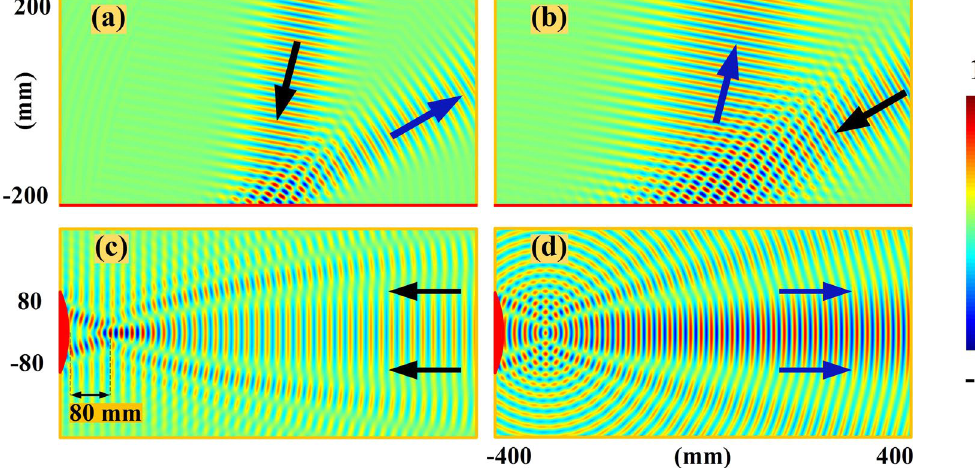
Figure 2. The near-fields of the negative reflection properties from the meta-mirrors. The demonstrations are based on the real part of the E-fields at 15 GHz, and the gradient phase layer of the meta-mirrors are all assumed to zero thickness using proper boundary conditions. ( a ) Planar meta-mirror with 10° incidence and − 60° reflection. ( b ) Planar meta-mirror with 60° incidence and − 10° reflection. ( c ) The focusing of rays from the convex meta-mirror when excited by a plane wave. ( d ) The collimation of rays from the convex meta-mirror when excited by a line source at the focal